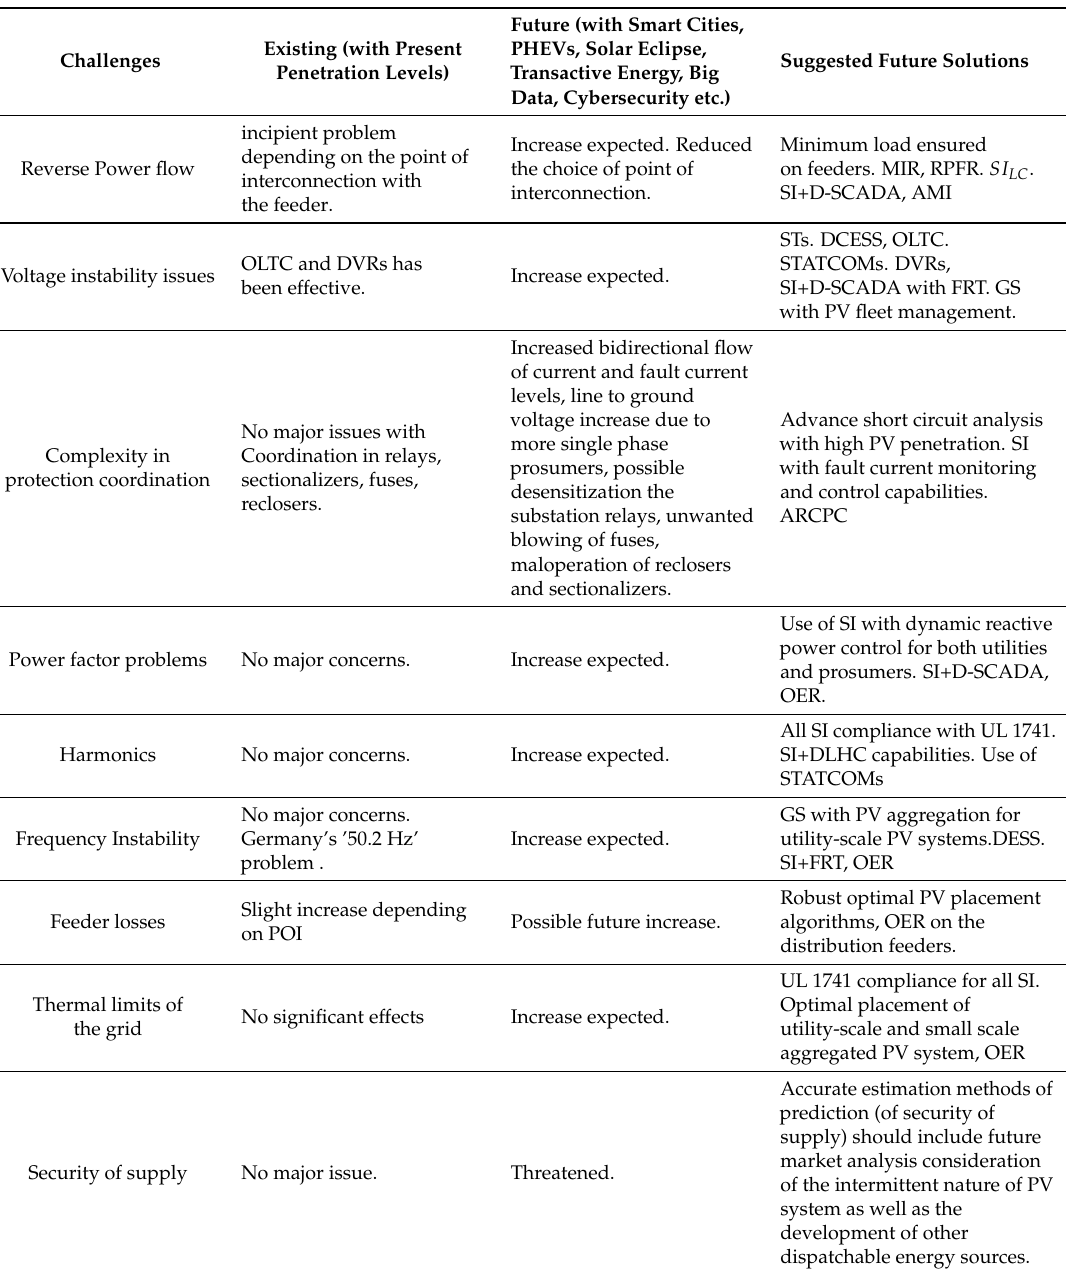
Table 3. PV penetration problems and suggested future